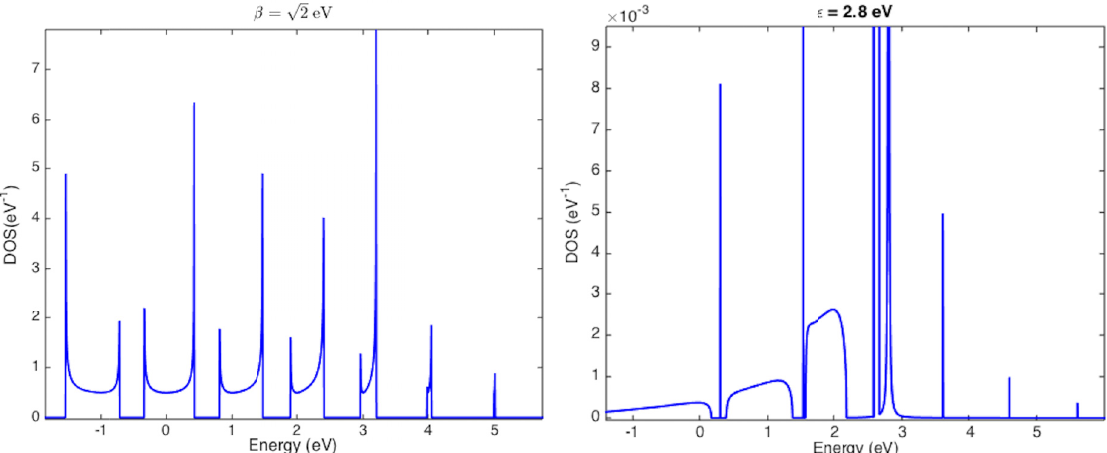
Fig. 8. Electronic structure as a function of the energy under the influence of coupling to the phonon modes. (Left panel) Far from the D-A interface. (Right panel) On the D-A interface. The hopping integral on the linear chain is J = 1 eV